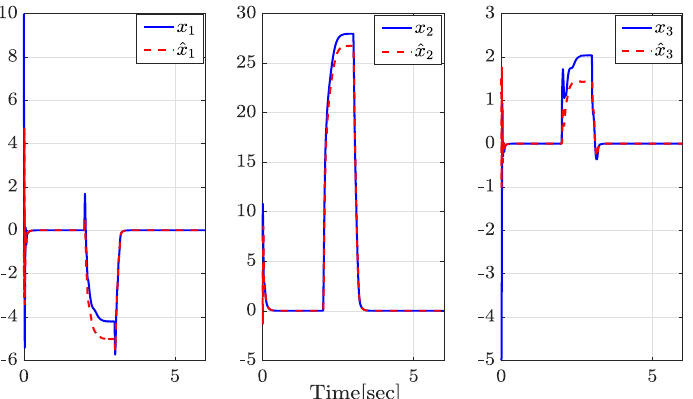
Figure 4. Evolution of the states x 1 , x 2 , x 3 (solid line) and their estimates (dashed line) using the sliding window